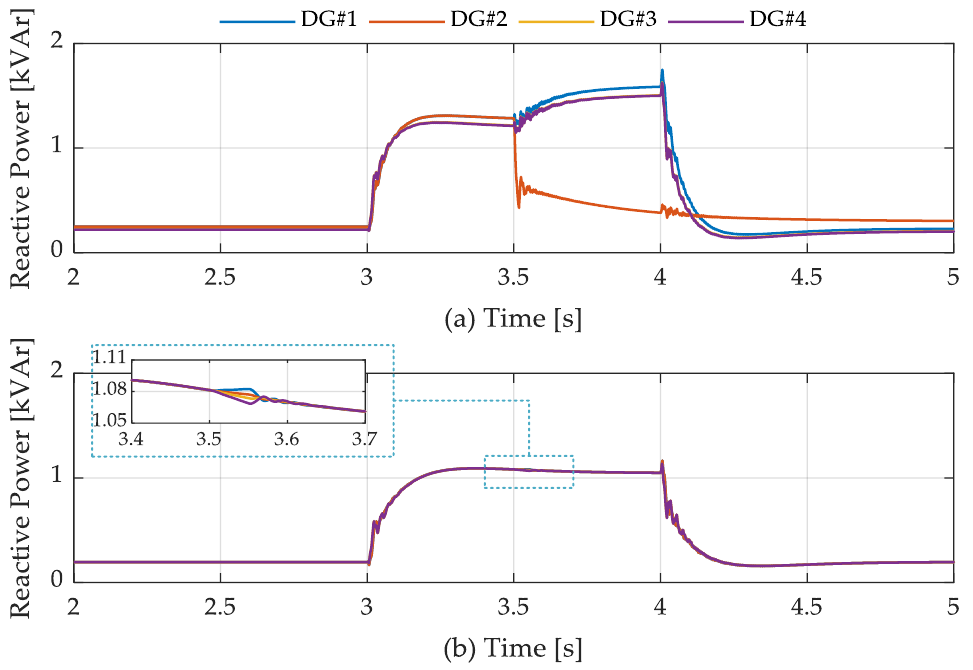
Figure 12. Output reactive power of each DG: ( a ) centralized method; ( b ) proposed method. Energies 2018 , 11 , x 14 of 18